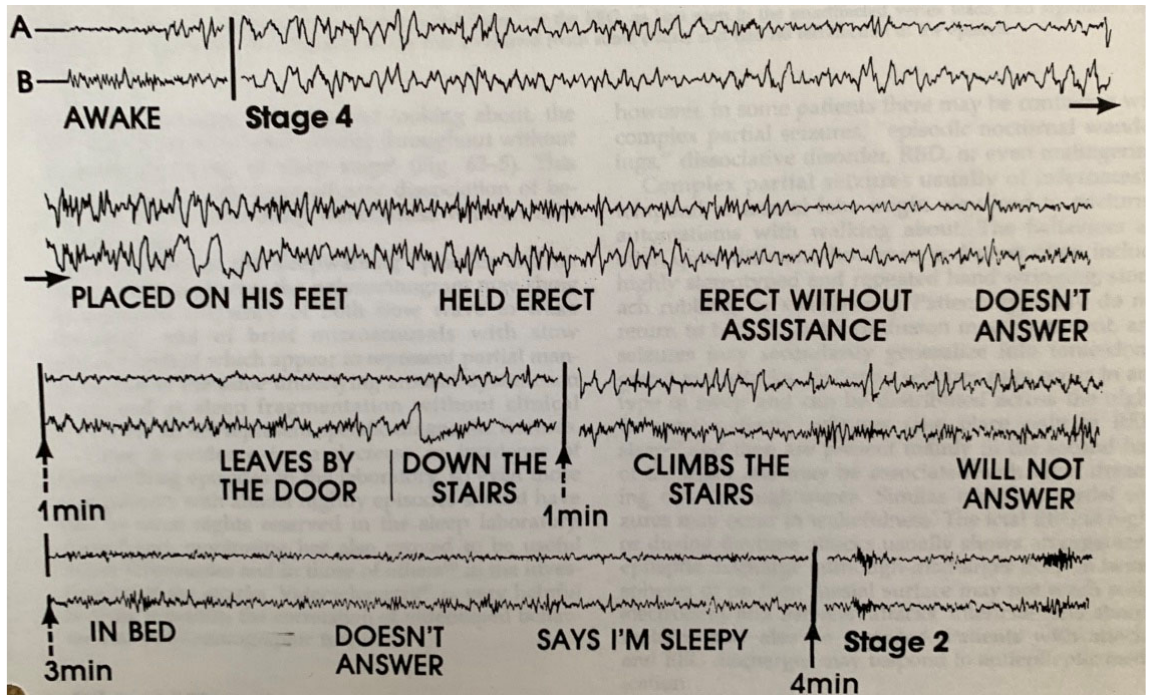
Figure 8. A sleepwalking episode inducted by simply lifting a child sleepwalker out of bed and putting him on his feet. The recording was made using a four-channel Alvar telemetry system. The child is erect without assistance and does not initially respond to questioning. He then exits the bedroom, and descends two stairs. During a minute of recording that is removed, he walked some 10 m, turned around, then climbed back up the stairs. He still did not respond to questioning, climbed into bed again, did not answer, and at last says “I am sleepy” and 4 min later is in stage 2 sleep with spindles. (Adapted from Gastaut, H. and Broughton, R.: A clinical and polygraphic study of episodic phenomena during sleep. Academic Address, in: Wortis, J. (Ed.), Recent Advances in Biological Psychiatry, New York, Plenum Press, 1965, pp.